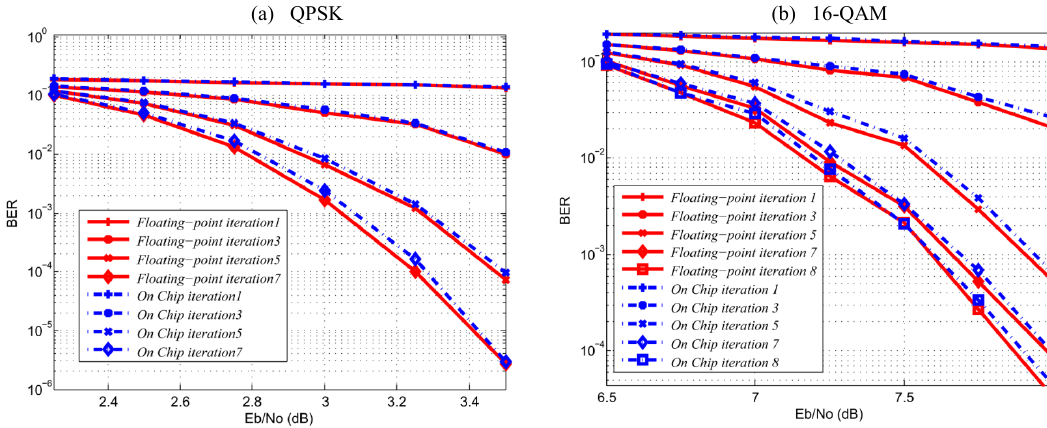
Figure 16. Comparison between the simulated reference BER and measured BER after on-chip evaluation of the designed equalizer for 1536 source bits, a 1 Rayleigh